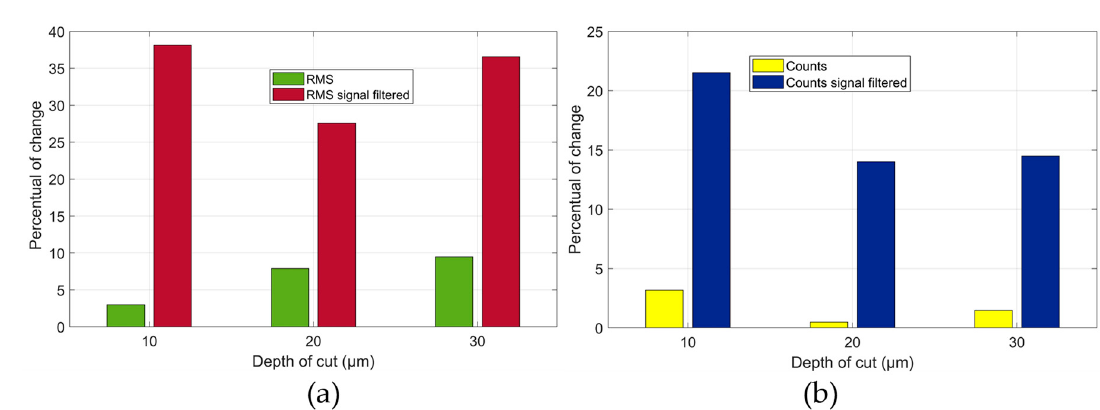
Figure 13. Percentage variation between the unfiltered and filtered signals of the workpiece without removal material and after the 3rd grinding pass—( a ) RMS and ( b ) Counts values.